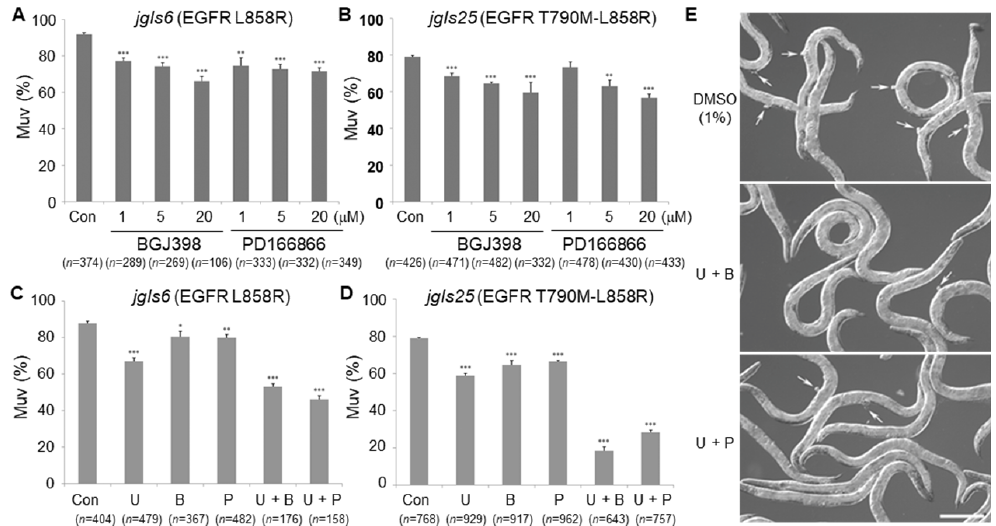
Figure 6. Effects of FGFR and MEK inhibitors on Muv formation. ( A , B ) Muv worms ( jgIs6 and jgIs25 ) were treated with indicated concentrations of FGFR inhibitors, BGJ398 and PD166866, and then worms with Muv were counted. The jgIs6 and jgIs25 strains express the EGFR-TKI-sensitive EGFR L858R and the EGFR-TKI-resistant EGFR T790M-L858R, respectively. ( C , D ) Muv worms ( jgIs6 and jgIs25 ) were treated either with 1 µ M MEK inhibitor U0126 (U), 5 µ M BGJ398 (B), 5 µ M PD166866 (P), 1 µ M U + 5 µ M B, or 1 µ M U + 5 µ M P, and worms with Muv were counted. ( E ) DIC images of the jgIs25 strain treated with indicated drugs. Arrows indicate Muv. Scale bar = 200 µ m. U = U0126. B = BGJ398. P = PD166866. Error bar = SEM. (* p < 0.05, ** p < 0.01, and *** p < 0.001 versus Con). These experiments were performed three times with comparable